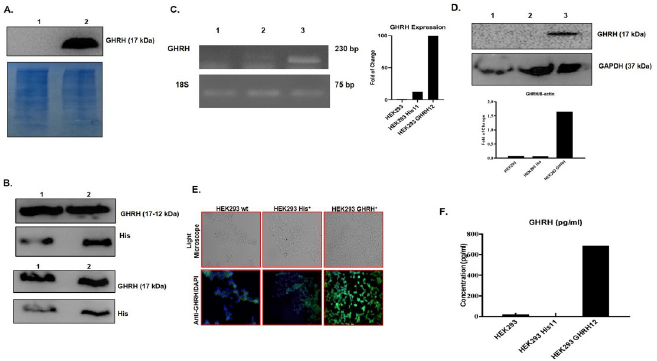
Fig 1. Obtaining and purification of His-tagged GHRH (1–44) ligand for the aptamer selection. A GHRH (1–44) expression of bacterial colonies expressing His- and His-GHRH vectors demonstrated by immunoblotting. 1 E . coli HB101 His vector clone, 2 E . coli HB101 His-GHRH vector clone. B Purified His tagged bacterial GHRH 1–44 ligand was demonstrated by immunoblotting via anti-GHRH and anti-His tag antibodies, respectively. 1 His-GHRH expressing total bacterial lysate, 2 His-GHRH expressing solubilized pellets. Eukaryotic GHRH NH2 (1–44) expression in His-GHRH vector-transfected HEK293 cells was identified by C qRT-PCR, D immunoblotting, and E immunofluorescence. 1 HEK293 wt 2 HEK293 His-transfected 3 HEK293 His-GHRH transfected. F GHRH 1–44 concentration in the media of HEK293 cells was measured by Human GHRH ELISA. GAPDH was used as a loading control. 18S was used as an internal control. DAPI was used to indicate the nuclei of the